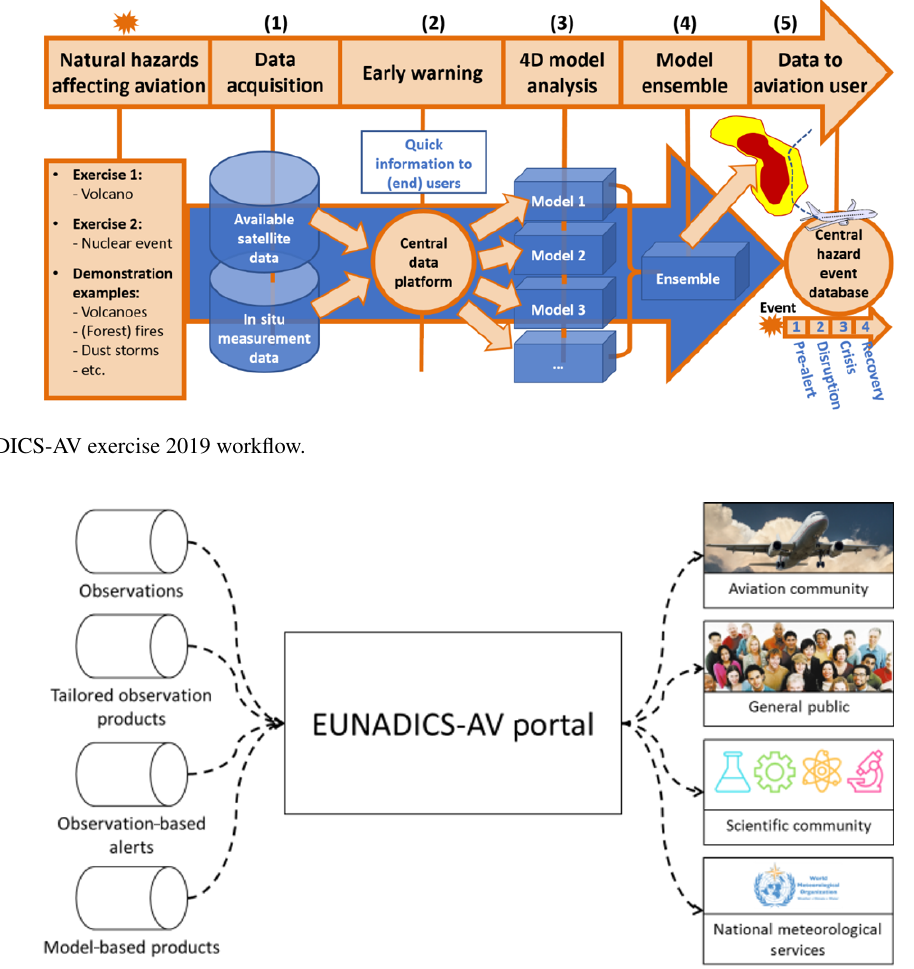
Figure 4. Information flow between data providers and